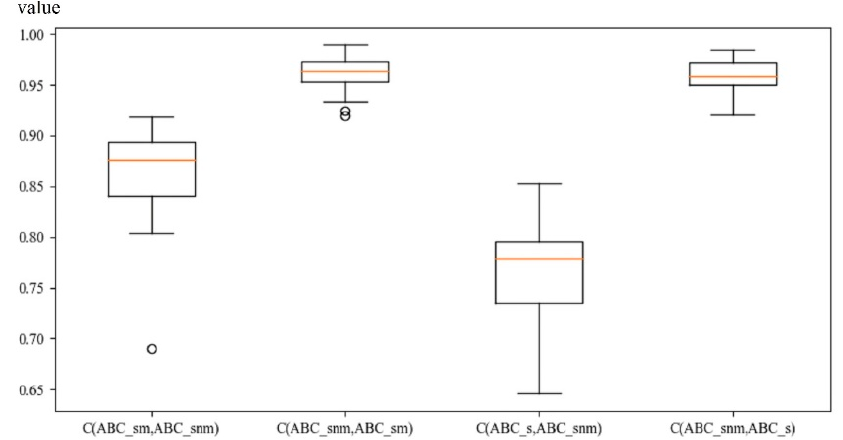
Figure 4. C -metric boxplot for ABC_sm, ABC_snm, and ABC_s.